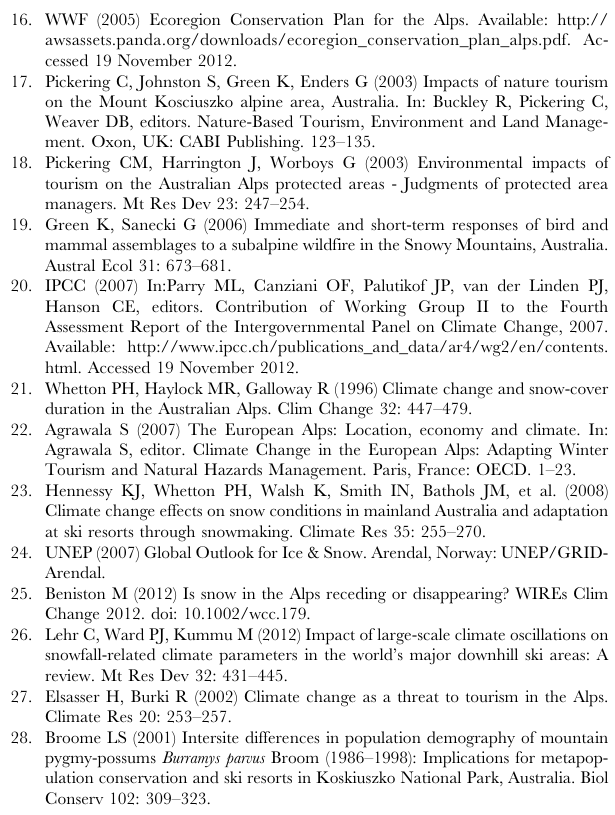
Table S1 Systematic Review and Meta-analysis Proforma.